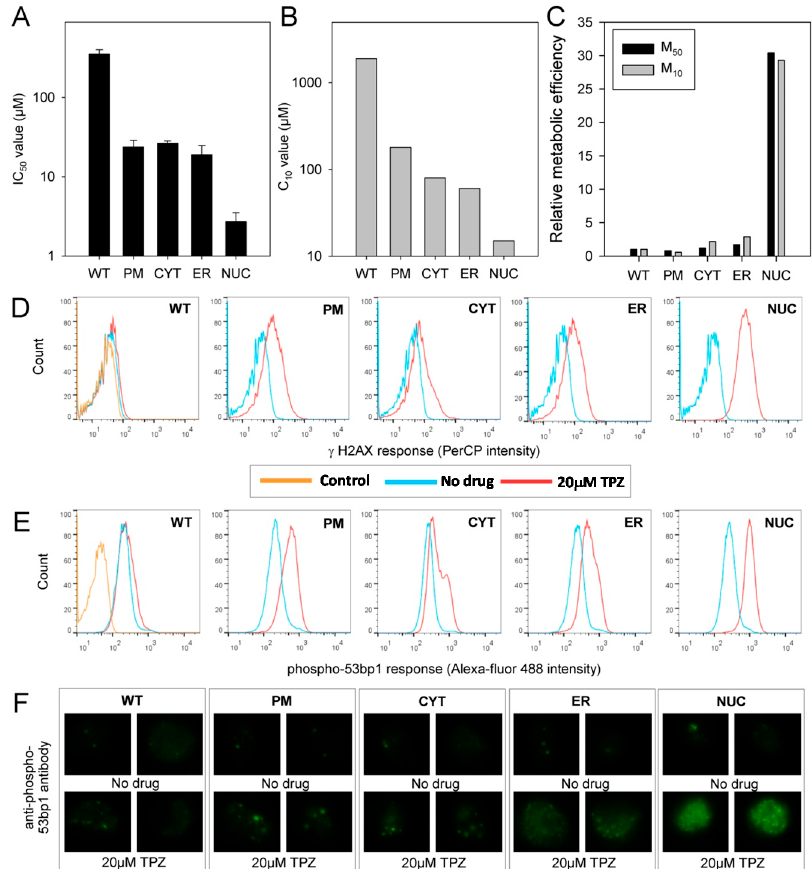
Figure 5. TPZ cytotoxicity under aerobic conditions displays major bias towards cells with POR localized in the nuclear compartment: ( A ) Sensitivity of parental and transfected MDA-231 cell lines to TPZ under aerobic conditions as determined by antiproliferative assay. IC 50 values show the mean of 2-4 independent experiments, error bars show the SEM; ( B ) Sensitivity of parental and transfected MDA-231 cell lines to TPZ under aerobic conditions as determined by clonogenic assay. C 10 values are derived from a single experiment (triplicate plates per drug concentration); ( C ) Relative metabolic efficiency in MDA-231 transfectants (extent to which productive metabolism contributes to cytotoxicity). M 50 = 1/(IC 50 × k met ) of anoxic TPZ activity as derived from Figure 3A. M 10 = 1/(C 10 × k met ) of anoxic TPZ activity as derived from Figure 3A). The M 50 and C 10 values were normalised to the value for MDA-231 WT cells; ( D ) Flow cytometry analysis of γ -H2AX levels in parental and transfected MDA-231 cells following a 4 h aerobic exposure to 20 µM TPZ and a 1 h drug-free recovery period under aerobic conditions. Control is no antibody labelling; ( E ) Flow cytometry analysis of phospho-53bp1 levels in parental and transfected MDA-231 cells following a 4 h aerobic exposure to 20 µM TPZ and a 1 h drug-free recovery period under aerobic conditions. Control is secondary antibody only; ( F ) Immunofluoresence microscopy showing phospho-53bp1 foci formation following a four hour aerobic exposure to 20 µM TPZ and a 1 h drug-free recovery period under aerobic conditions.